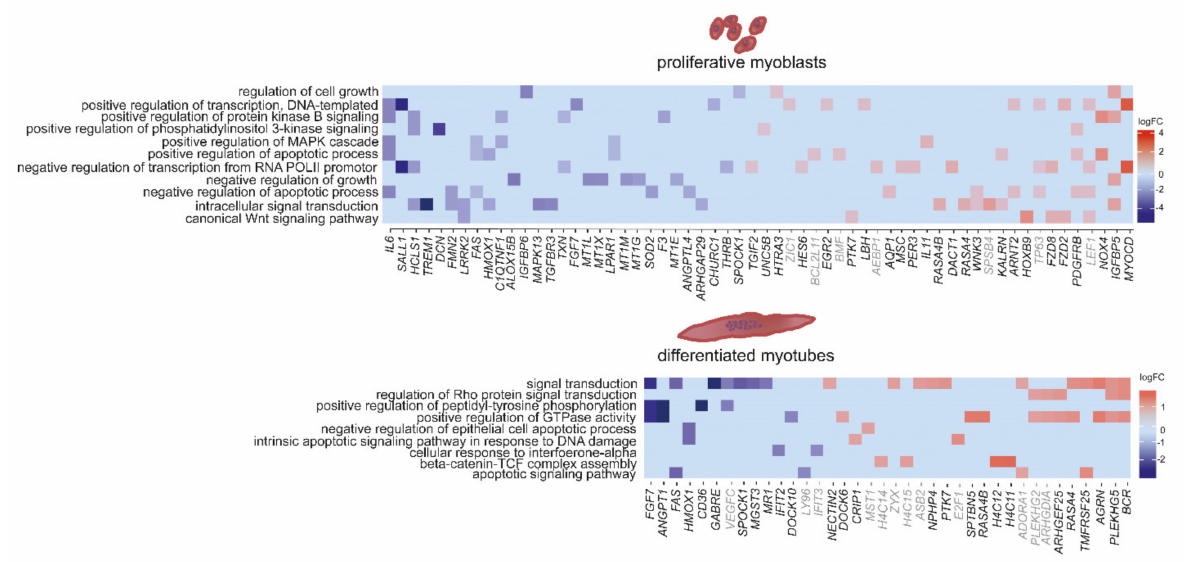
Figure 3. Heat maps showing differences in expression between non-disease controls and DM1 for genes linked to signalling pathways in proliferating myoblasts ( upper panel ) and differentiated myotubes ( lower panel ). Gene names displayed in grey: p -value < 0.1, in black: p -value <